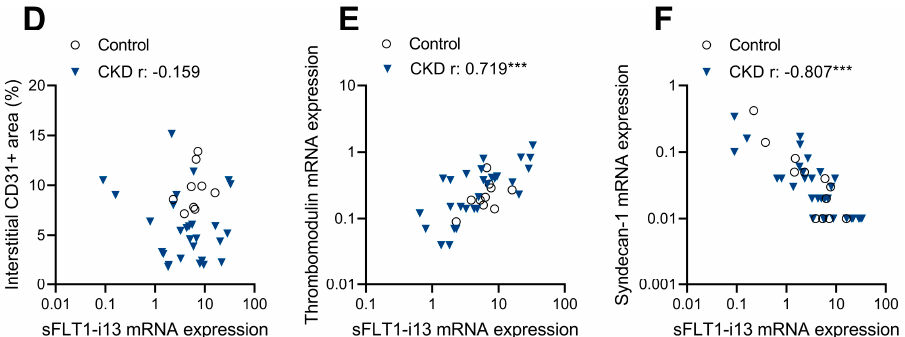
Figure 5. Renal sFLT1 transcript levels are not associated with human CKD. Renal sFLT1-i13 and sFLT1-e15a transcript levels were measured in fibrotic kidney biopsies obtained from patients with diabetes-related CKD (CKD) and in control kidney tissues. ( A ) Renal sFLT1-i13 and ( B ) sFLT1-e15a mRNA levels are not increased in CKD kidneys compared to control kidneys. Independent samples t -test of log-transformed mRNA expression. Correlation plots of renal sFLT1-i13 gene expression with ( C ) Sirius red staining, ( D ) CD31 immunostaining, ( E ) thrombomodulin mRNA expression and ( F ) syndecan-1 mRNA expression split per group. Bivariate Pearson correlations of log-transformed mRNA levels. *** p <